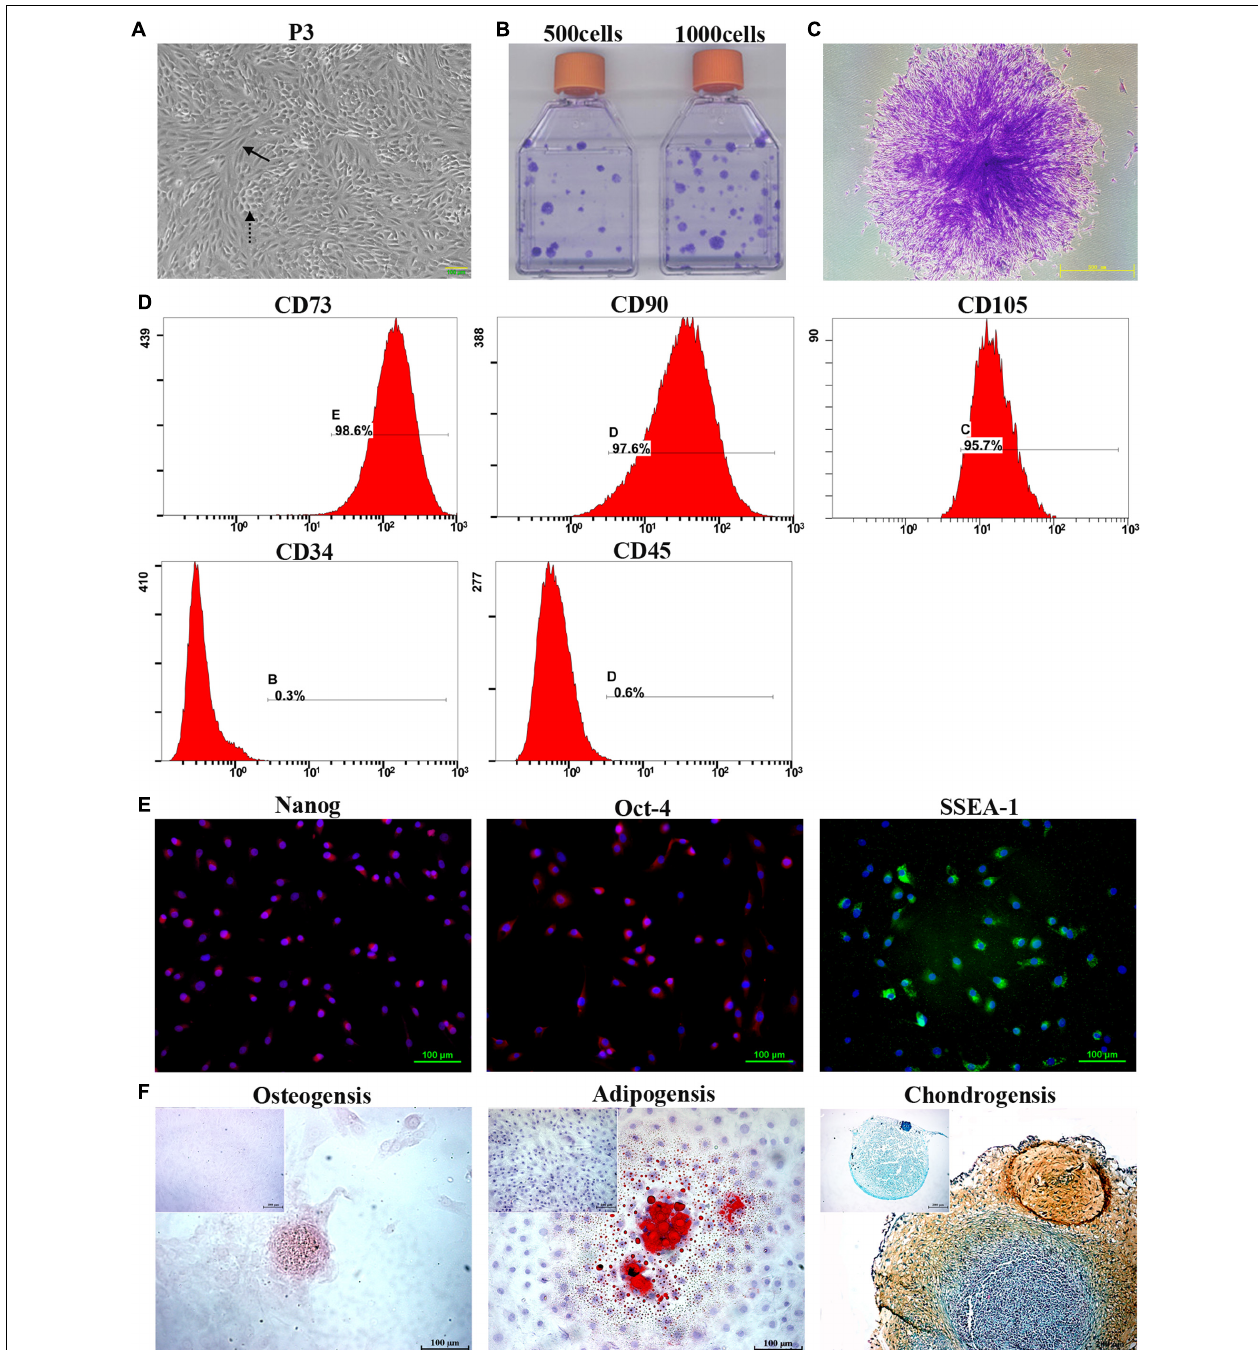
FIGURE 1 | Isolation and characterization of mTDSCs. (A) Morphology of mTDSCs at P3. These cells were fibroblast-like morphology (solid arrow) or cobblestone-like morphology (dotted arrow). (B ) Crystal violet staining of colonies formed by mTDSCs. (C) Representative image of a single clone. (D) Flow cytometry analysis of the expression of cell surface markers related to MSCs, hematopoietic stem cells, and endothelial cells on mTDSCs. (E) Immunofluorescent staining of stem cell markers for mTDSCs. Scale bar = 100 µ m. (F) Multidifferentiation potential of mTDSCs toward osteogenesis (Scale bar = 100 µ m), adipogenesis (Scale bar = 100 µ m) and chondrogenesis (Scale bar = 200 µ m) in vitro , as evidenced by Alizarin Red, Oil Red O, and Safranin O/Fast Green staining respectively. The upper left corner inset shows the mTDSCs in basic growth medium without such a multidifferentiation potential.